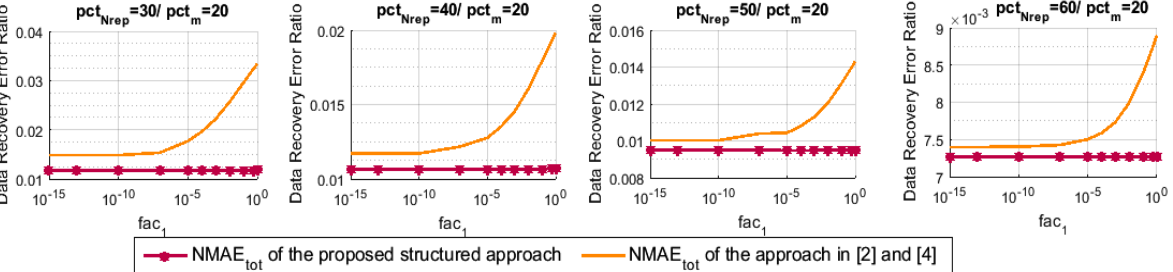
Figure 5. NMAE tot for the proposed technique and the one in [2,4].